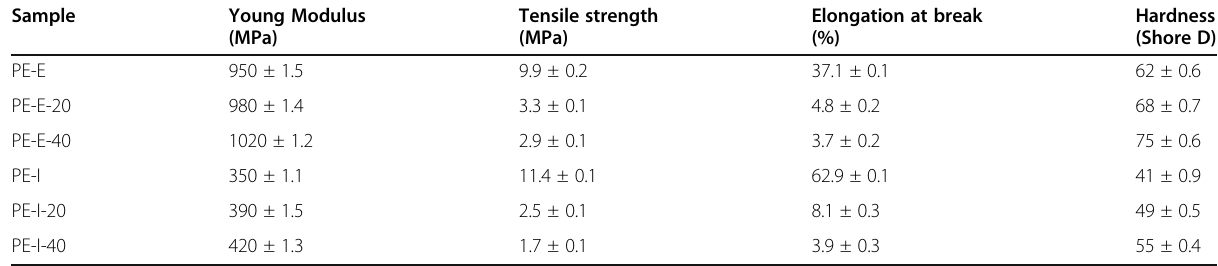
Table 5 Mechanical properties of pure polymers, and PE-E/CH and PE-I/CH composites